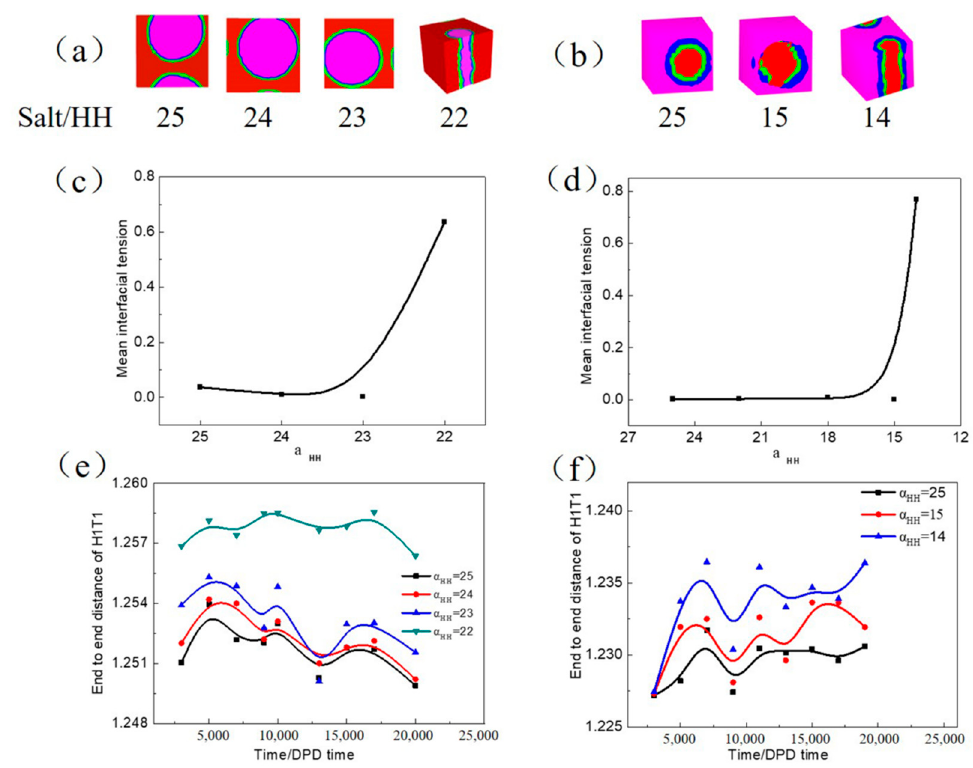
Figure 7. The translucent three-dimensional structure of microemulsion—( a , b ), the corresponding mean interfacial tension—( c , d ) and end to end distance of H1T1—( e , f ) with increasing inorganic salt. In which, ( a , c , e ) represent O/W microemulsion, ( b , d , f ) represent W/O microemulsion.